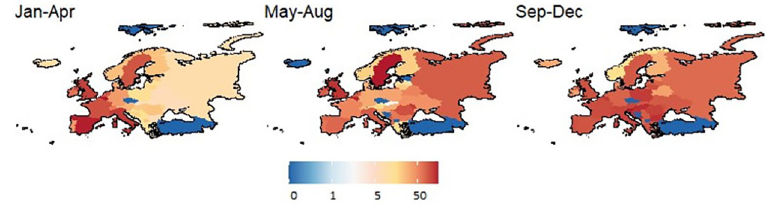
Fig 7. Observed new deaths per million due to COVID 19 in Europe,